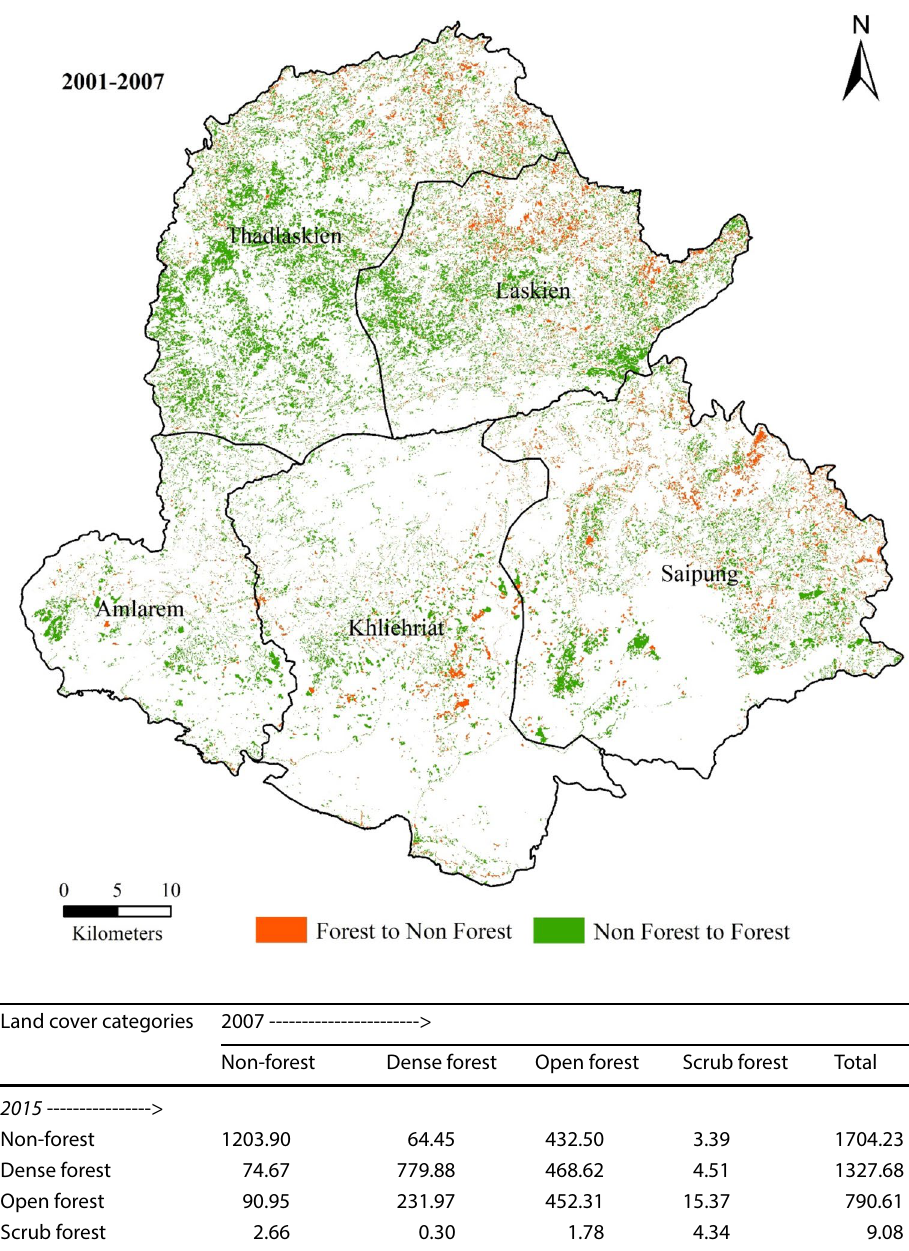
Fig. 5 Change in forest class map between 2001 and 2007